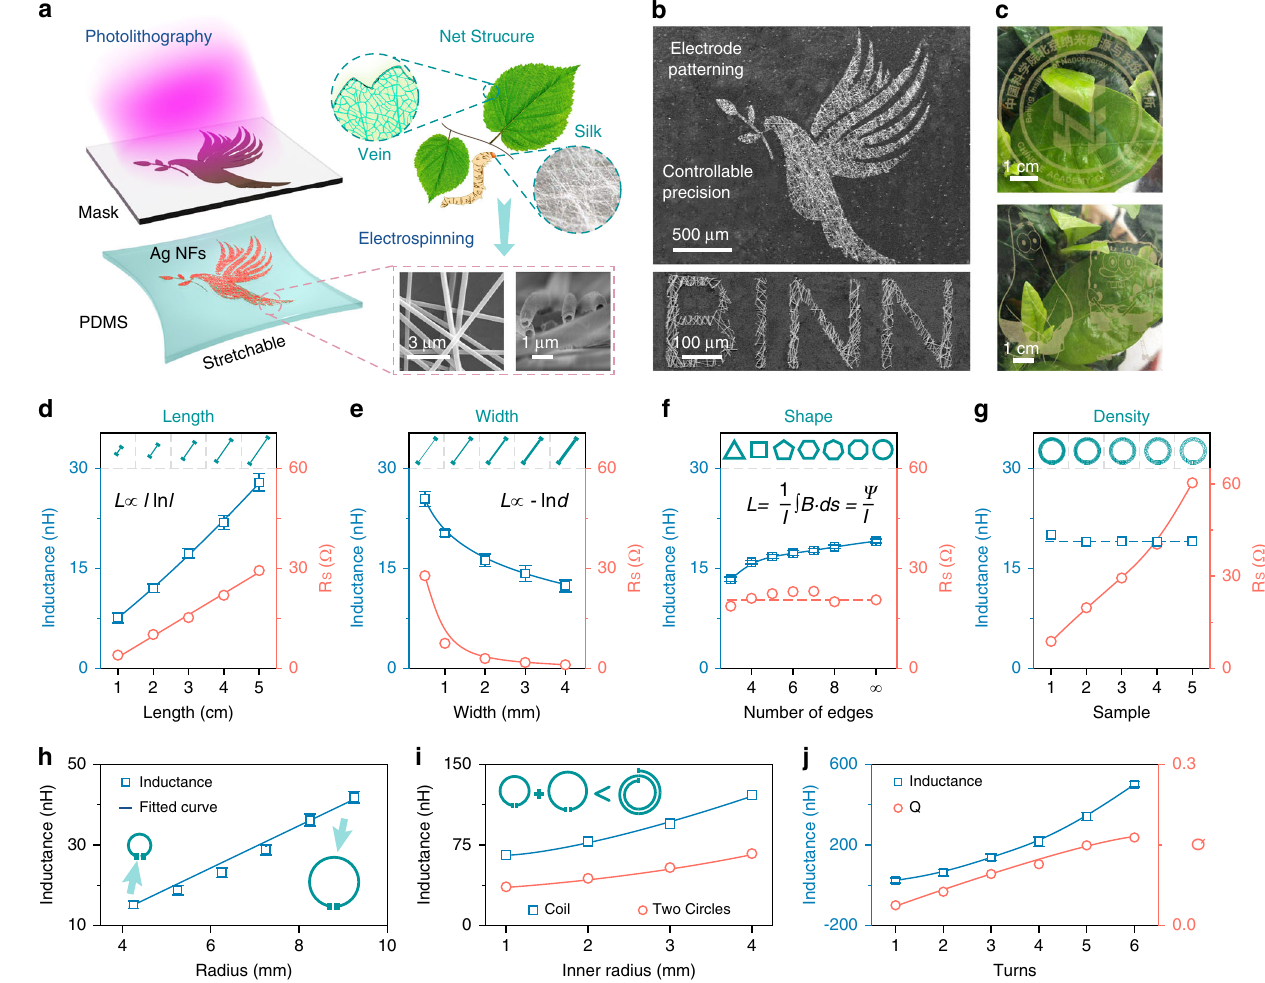
Fig. 1 Fabrication and characterization of high precision patterned Ag nano fi bers (Ag NFs) coil. a Concept illustration the fabrication process of Ag NFs electrode with bioinspired net structure. b SEM images of high-precision patterned Ag NFs electrode. c Digital photos of large-area patterned electrode on PDMS substrate. Inductance and resistance of different electrodes with change in ( d ) length, ( e ) width, ( f ) shape, and ( g ) density. h Inductance variation of circular electrodes with radius. i Inductance comparison between two-turn spiral coil and two single-turn circular electrodes. j L and Q variation of electrodes with number of